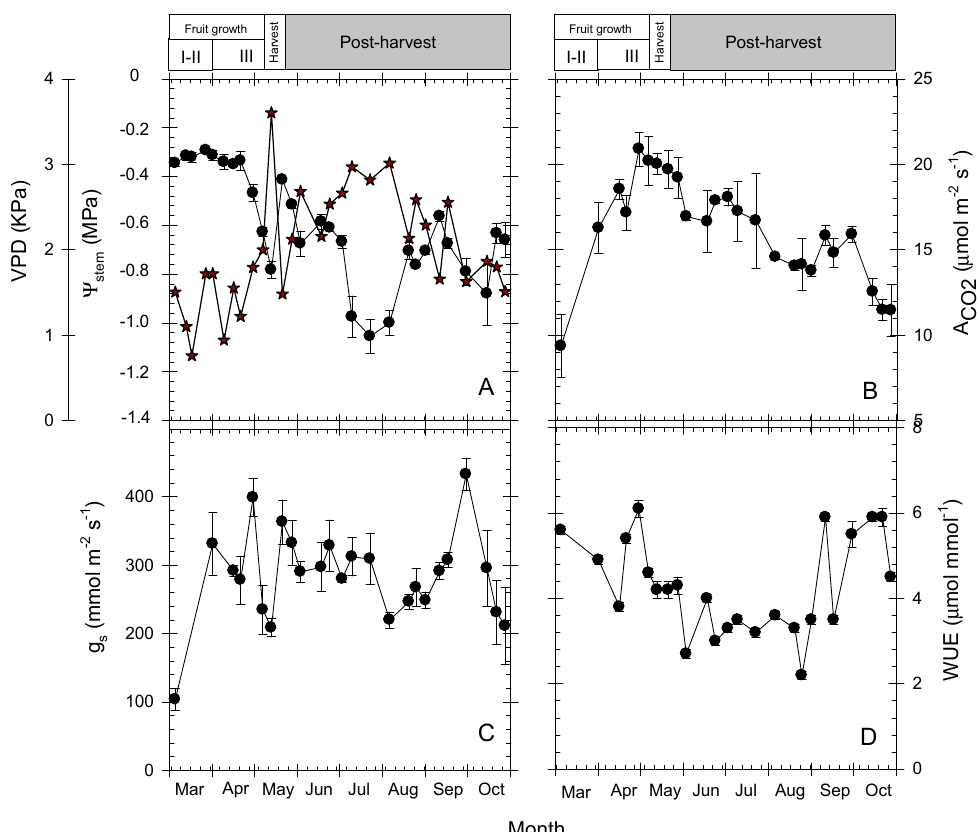
Figure 3. Mean values for ( A ) Midday stem water potential ( • , Ψ stem , MPa) and vapor pressure deficit Figure 4. Seasonal evolution of irrigation factor (IF, ), canopy tree cover (%, dashed line) for early-maturing nectarine trees, and daily precipitation (mm day − 1 , vertical bars) during the irrigation period. The red line represents the adjusted IF values to a curvilinear regression. Phenological stages for nectarine trees are depicted in the top box.